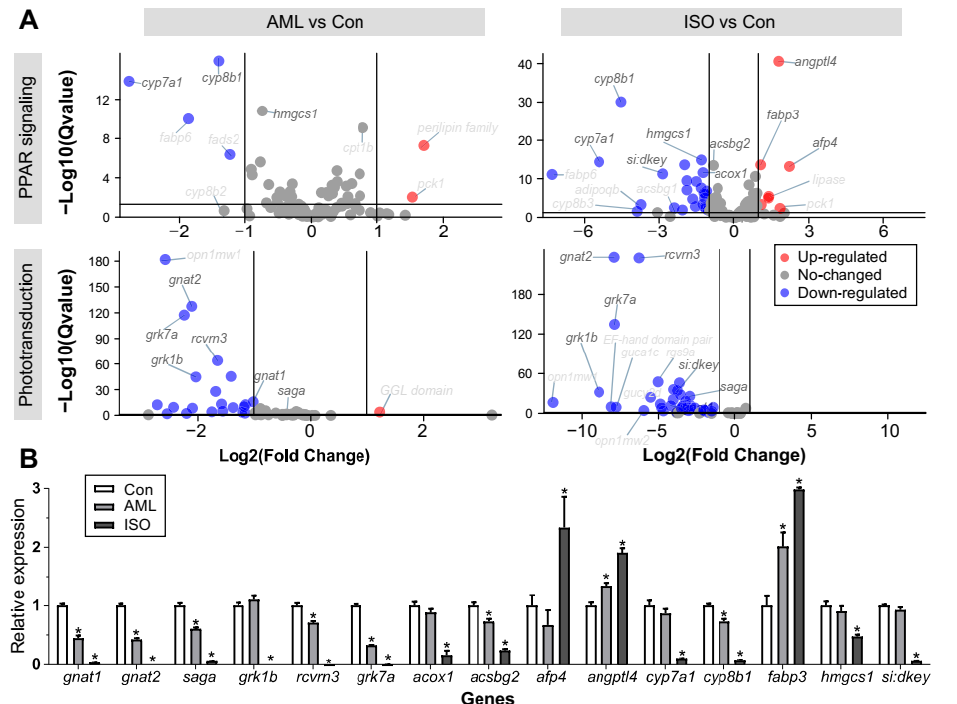
Figure 6. Volcano plots of DEGs in PPAR signaling and phototransduction pathways ( A ) and validation of the transcriptome analysis of selected DEGs using RT-qPCR ( B ). About the volcano plots, each dot represents a gene. The red and green dots represent differentially expressed genes with p < 0.05 and |log2 fold change| > 1, respectively. The gene names or descriptions of DEGs with low p values or high |fold change| were labelled, and the names or descriptions of genes selected in RT-qPCR were marked dark black. In regard to the RT-qPCR plot, significant differences between control (Con) and AML- or ISO-exposure groups are indicated by asterisks, respectively. * p <